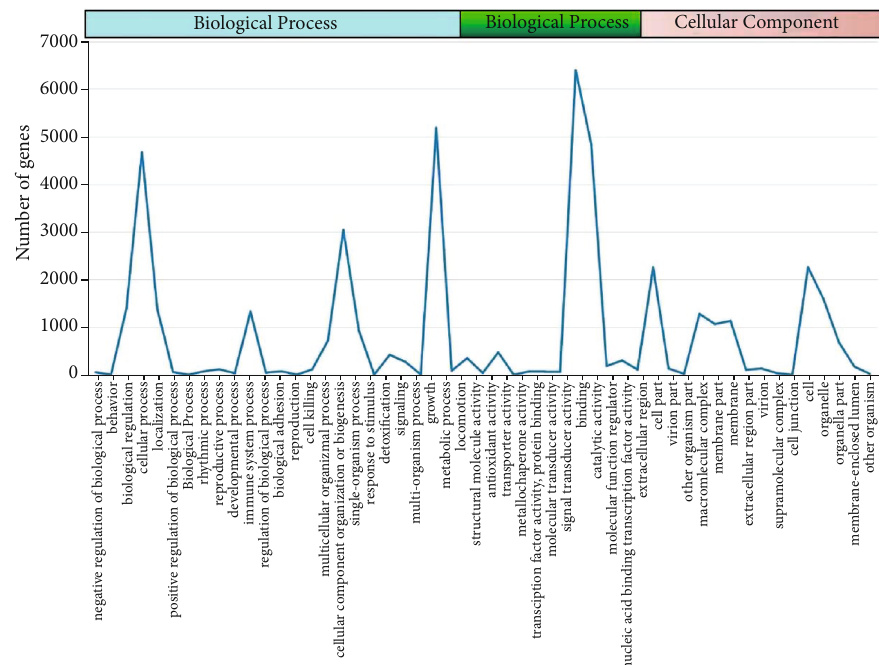
Figure 5: Venn maps of the unigenes among NR, GO, KEGG, Pfam, KOG, NT, and Swiss-Prot databases.